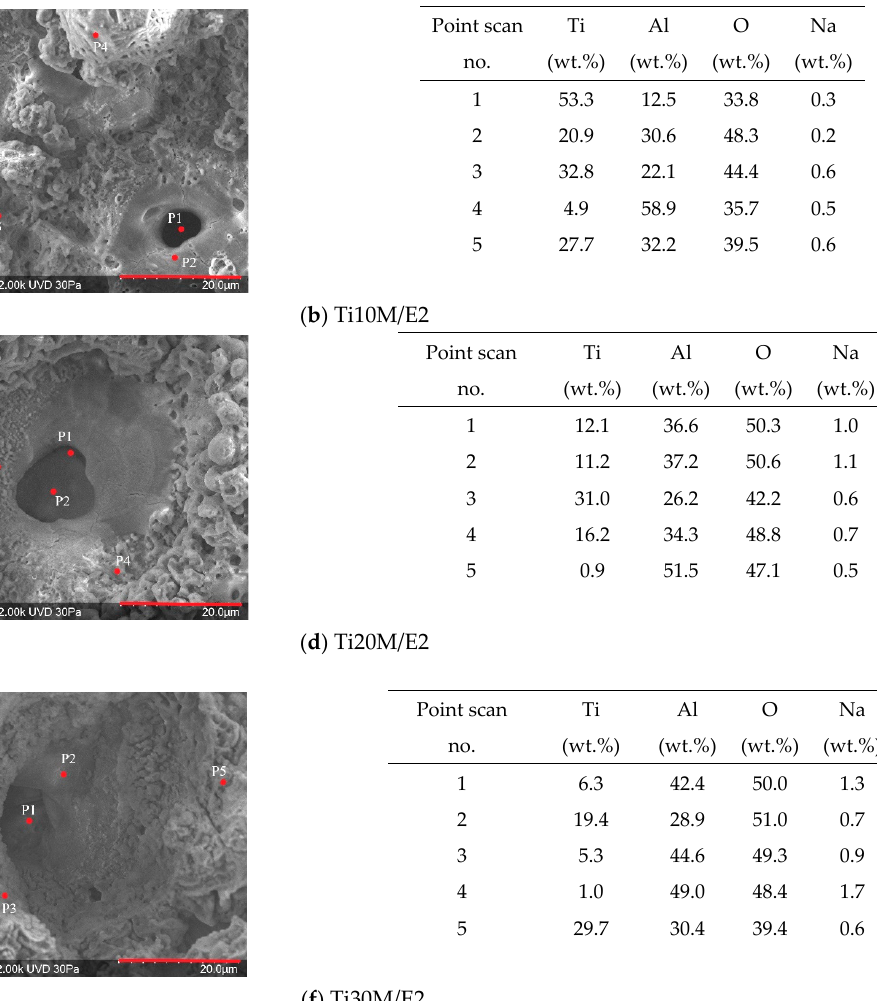
Figure 5. SEM images of the layers grown in E1 electrolyte after 10, 20 and 30 min treatment period: low magnification ( a , c , e ); high magnification and EDS analysis points ( b , d , f ); point element mass concentrations (wt.%).